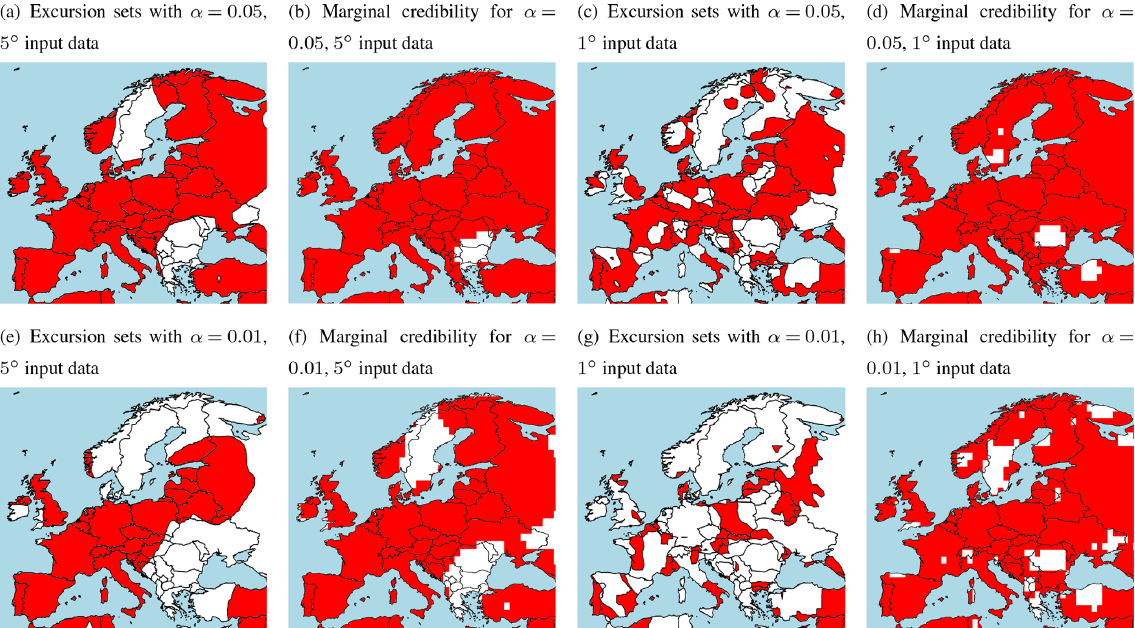
Figure 5. Significance assessment of trend estimates with red areas denoting locations where the null hypothesis of no trend is rejected based on avoidance excursion sets for simultaneous credible regions and marginal credible intervals for 5 and 1 ◦ data. All estimates have been extrapolated to the same 1 ◦ lattice prior to the significance assessment. The excursion set maps (a, c, e, g) are produced via the continuous() function of the R package excursions , thus reflecting their continuous nature as opposed to the lattice structure kept for the marginal credible intervals (b, d, f, h) . The upper panels display results at the 5% significance level, whereas 1% significance levels are found in the bottom